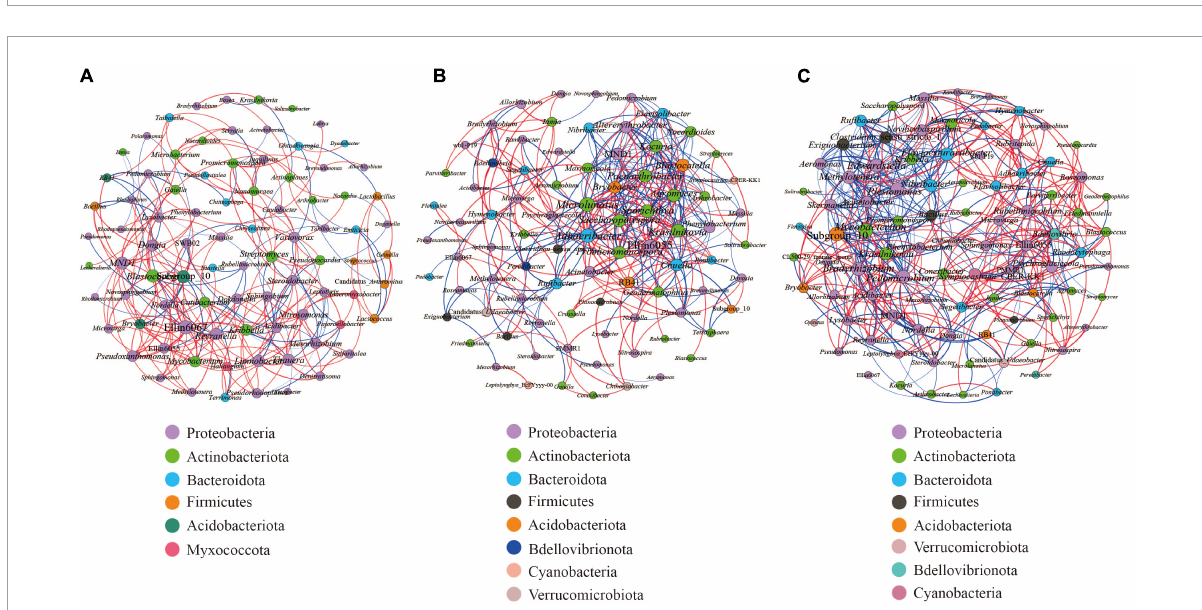
FIGURE9 Microbial interaction networks in the different compartments. The larger the circle layer of the species is, the greater the connection between the circle layer is, and the higher the correlation degree with other species is, which represents the core species in the correlation. Different colors represent the taxonomic distribution of the corresponding species at the gate level. The edge color indicates a positive (red) and negative (blue) correlation. The width of the edge represents the relevant value. Only a significant correlations ( r > 0.6 percent, P < 0.05) were shown. (A) is the co-occurrence network of the bacterial communities within the root nodule. (B) is the co-occurrence network of the bacterial communities within the rhizosphere soil. (C) is the co-occurrence network of bacterial communities within the bulk